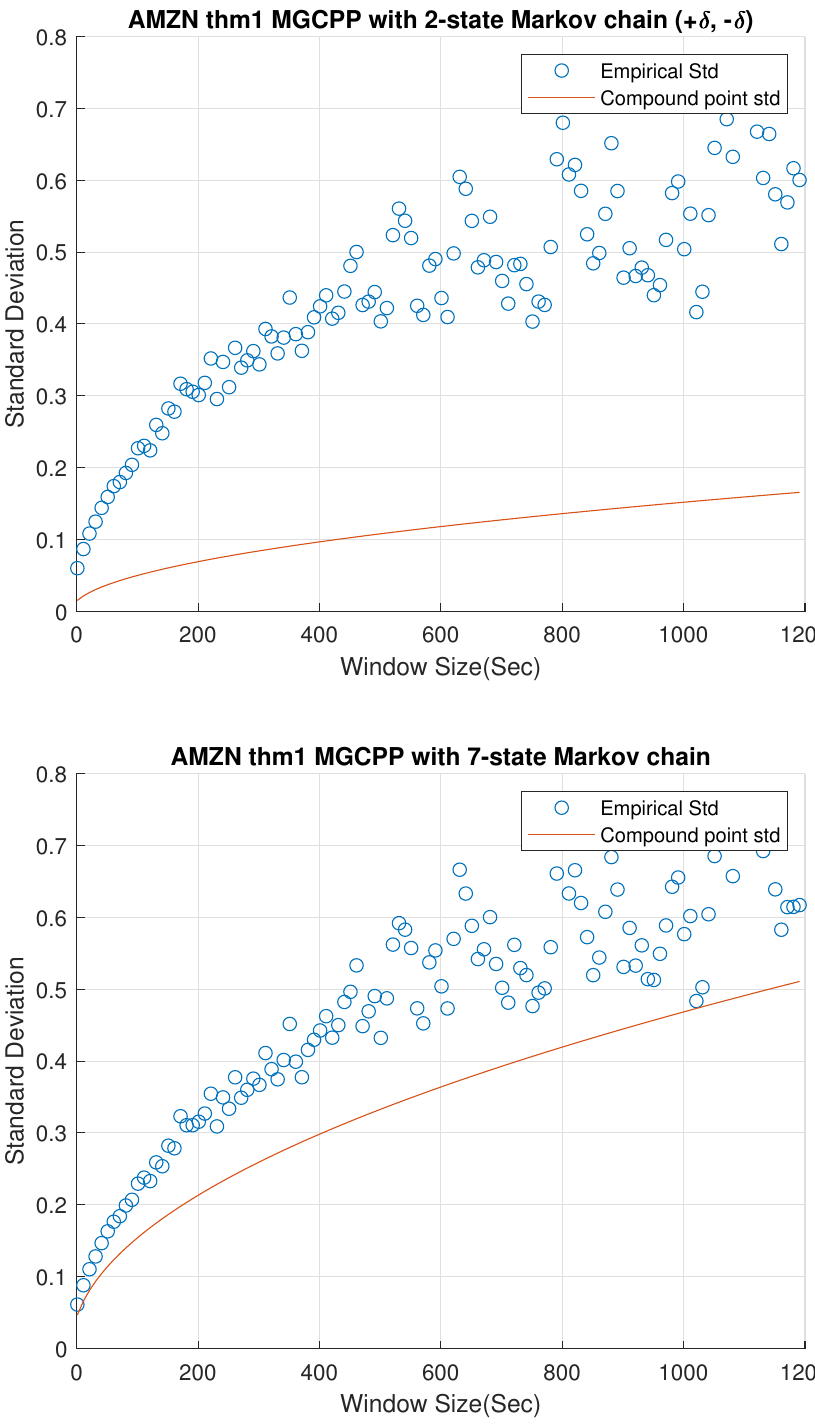
Figure 4. Standard deviation comparisons for MGCPP with 2-state Markov chain and 7-state Markov chain simulated by Amazon’s stock